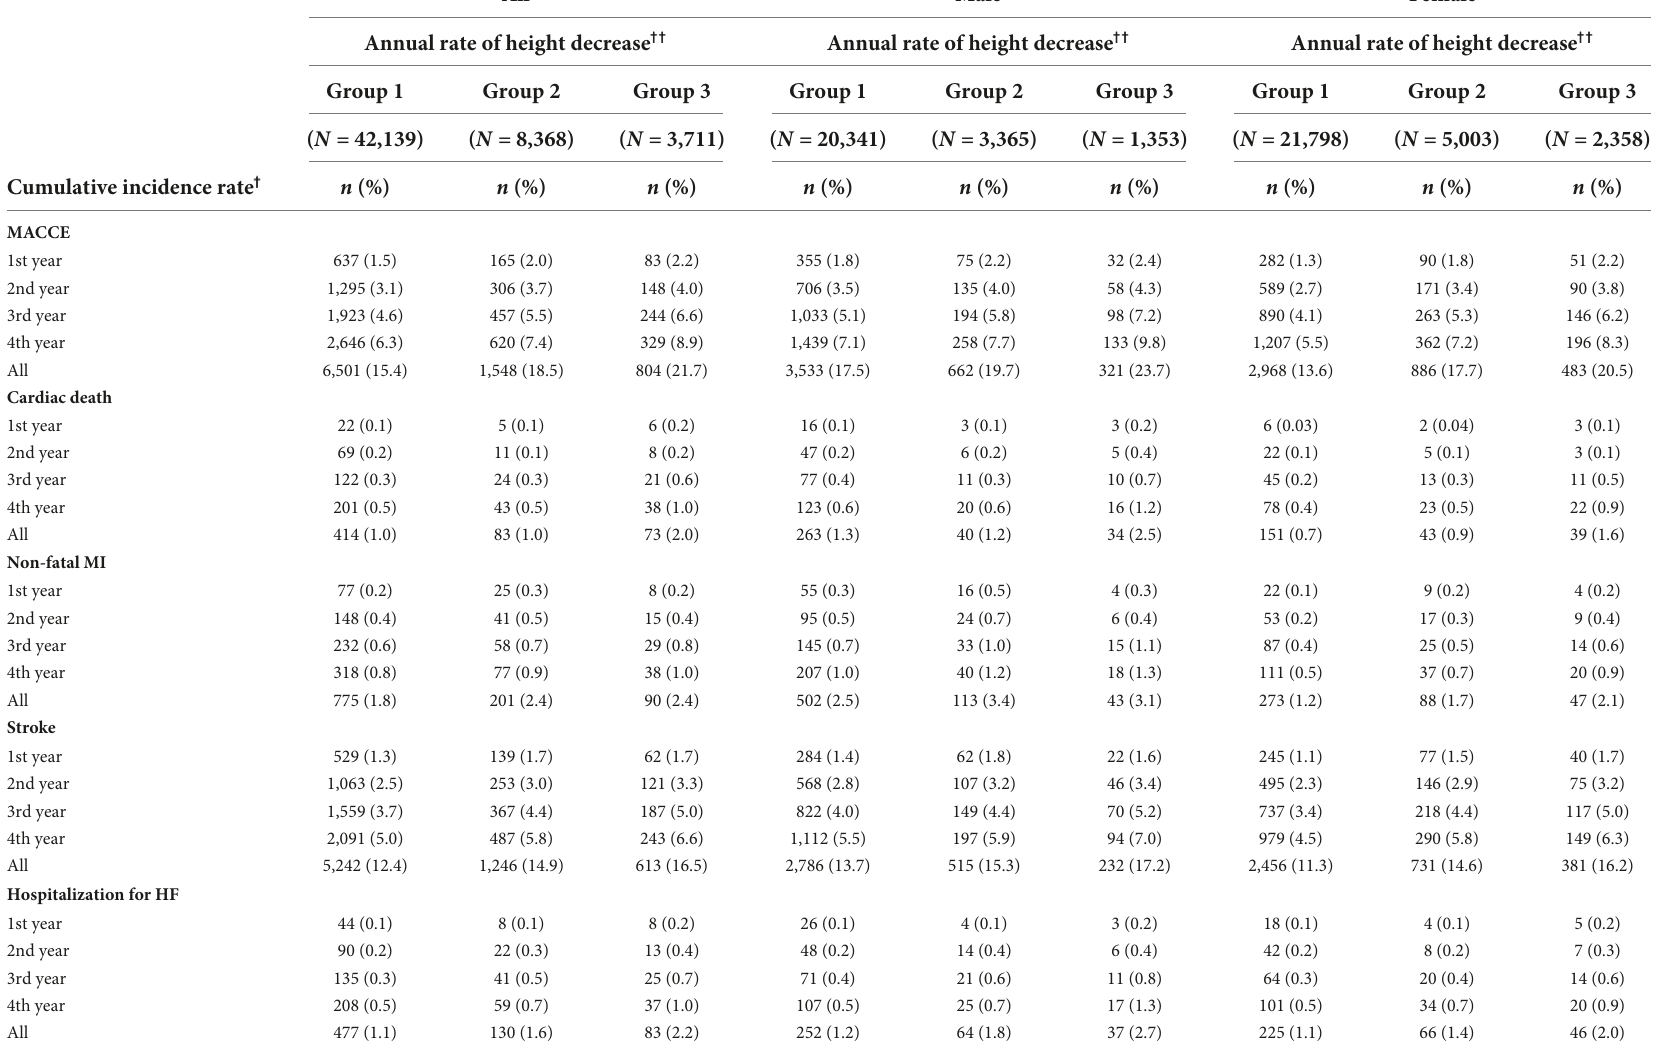
TABLE 4 The cumulative incidence rates of major adverse cardiovascular and cerebral events per the annual height decrease rate in patients aged ≥ 60 years. All Male